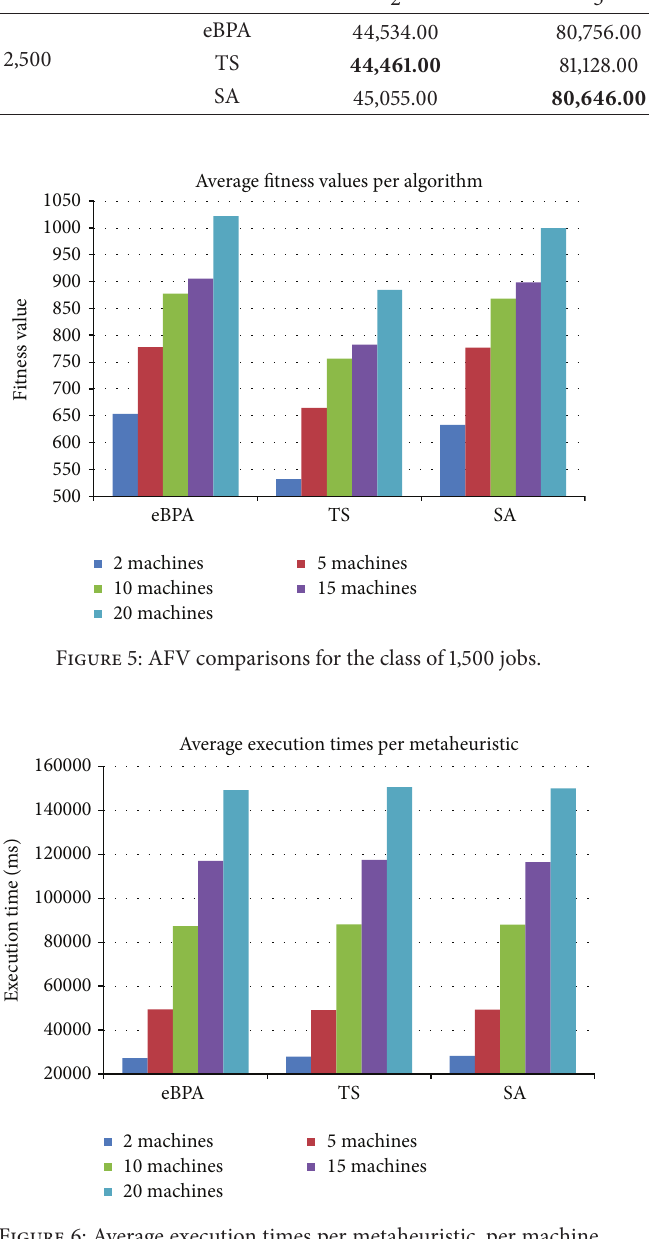
Figure 6: Average execution times per metaheuristic, per machine set, for the class of 1,500 jobs.